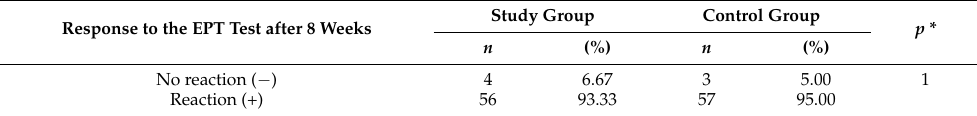
Table 5. Comparison of the response to the electrical stimulus of the teeth of the test group and the control group 8 weeks after treatment.